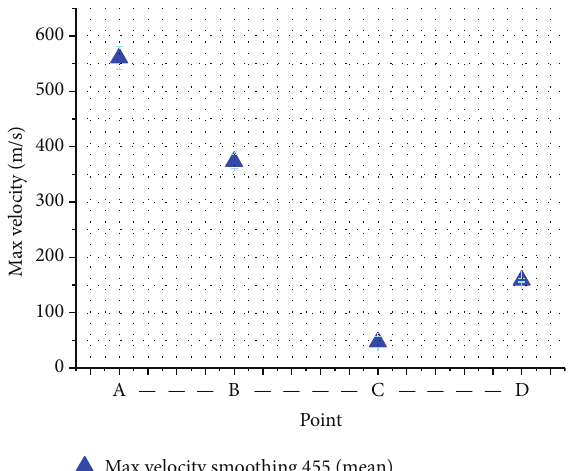
Figure 24: Maximum velocity values central line 100Pa 300 Pa/ s hot experiment.